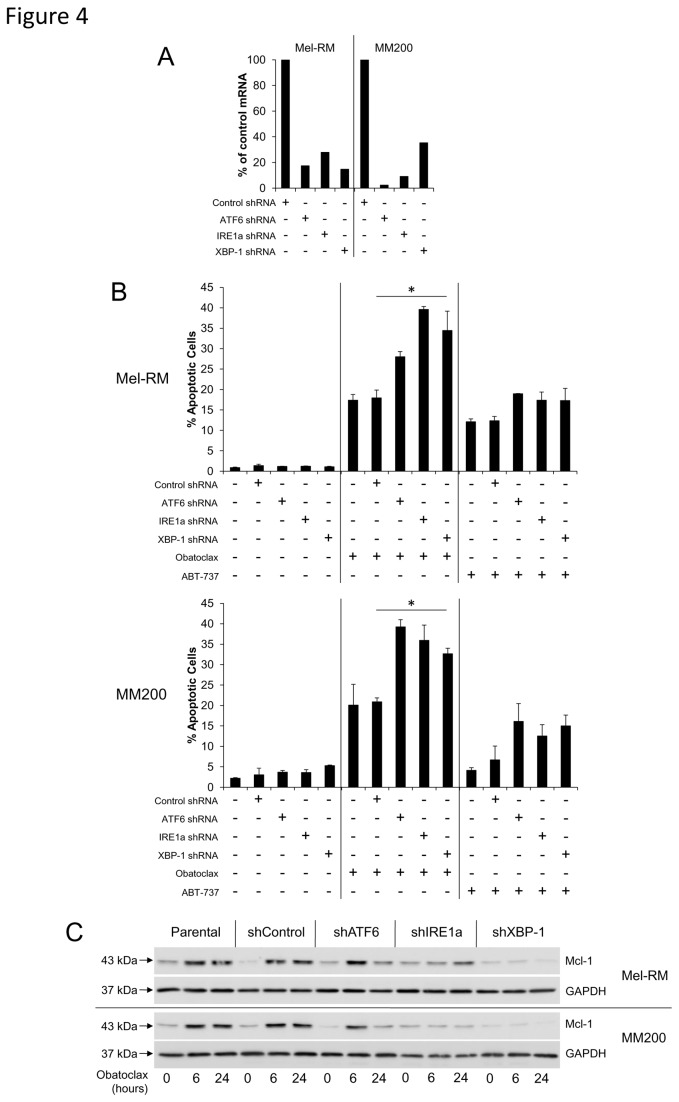
Inhibiting the UPR sensitises melanoma cells to Obatoclax- and ABT-737-induced cell death.A. Stable knockdowns of ATF6, IRE1α and XBP-1 were generated in Mel-RM and MM200 cells by retroviral insertion of shRNA. Transduced cells were selected with 5µg/ml puromycin. Knockdown of ATF6, IRE1α and XBP-1 was confirmed by real time-PCR.B. Following treatment of knockdown cells with Obatoclax (1µM) or ABT-737 (10µM) for 24 hours, measurement of apoptosis was performed by the propidium iodide method using flow cytometry. Columns, mean of three individual experiments; bars, SE.C. The stable knockdown cells were treated with Obatoclax (1µM) or ABT-737 (10µM) for indicated periods. Whole cell lysate was then subjected to Western blot analysis of Mcl-1 protein expression levels. Data are representative of three individual experiments.